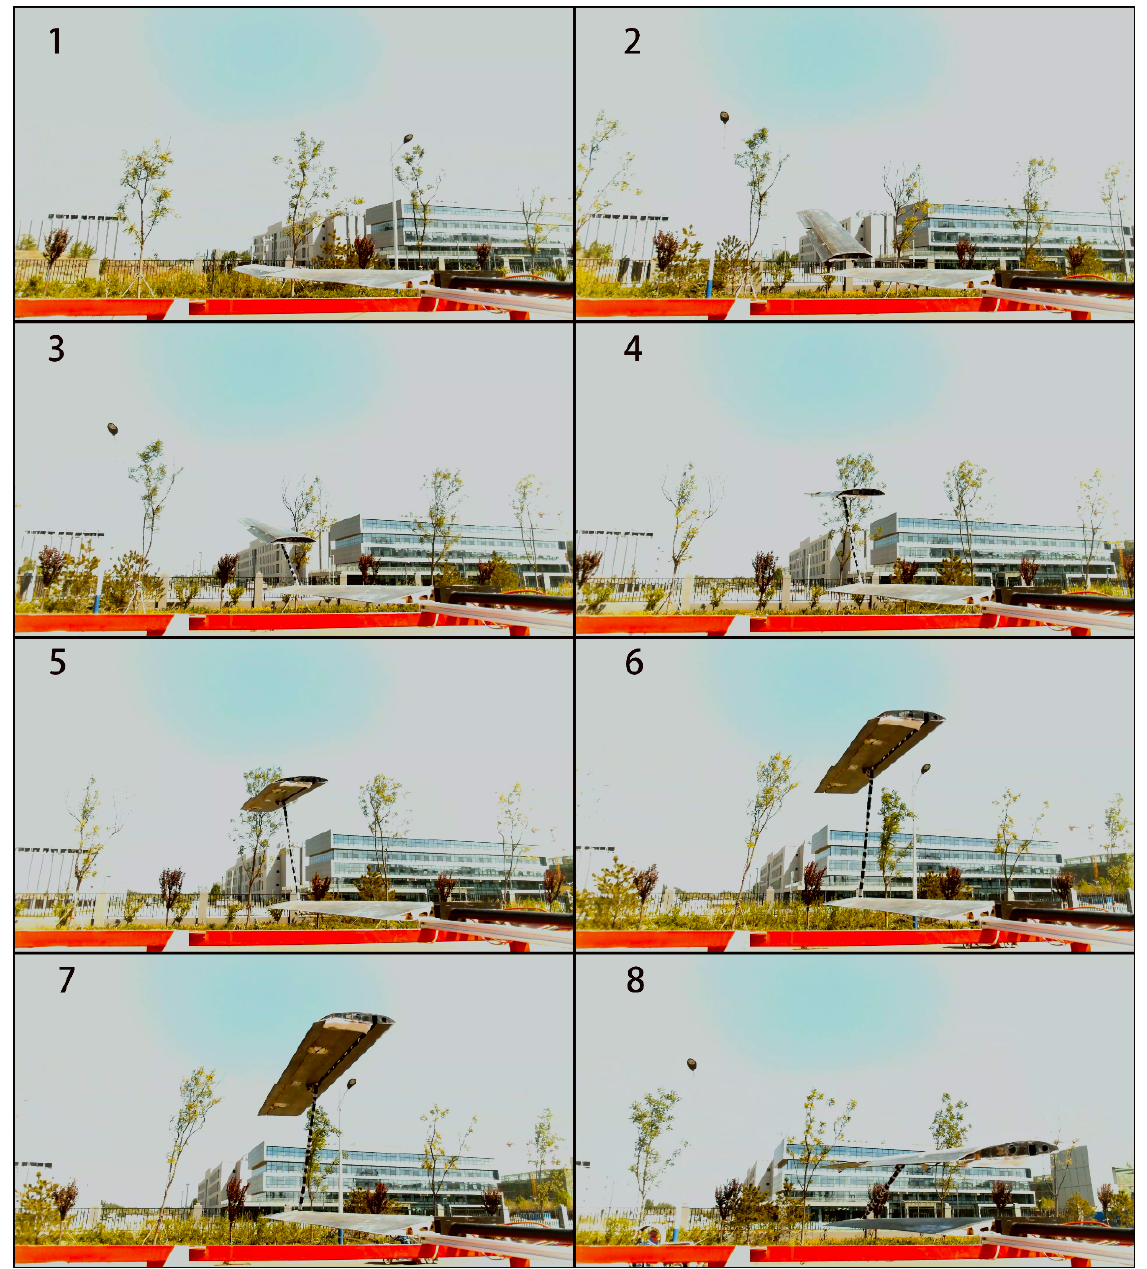
Figure 8. The folding process of the wings. 1 – 8 shows the process of morphing in chronological